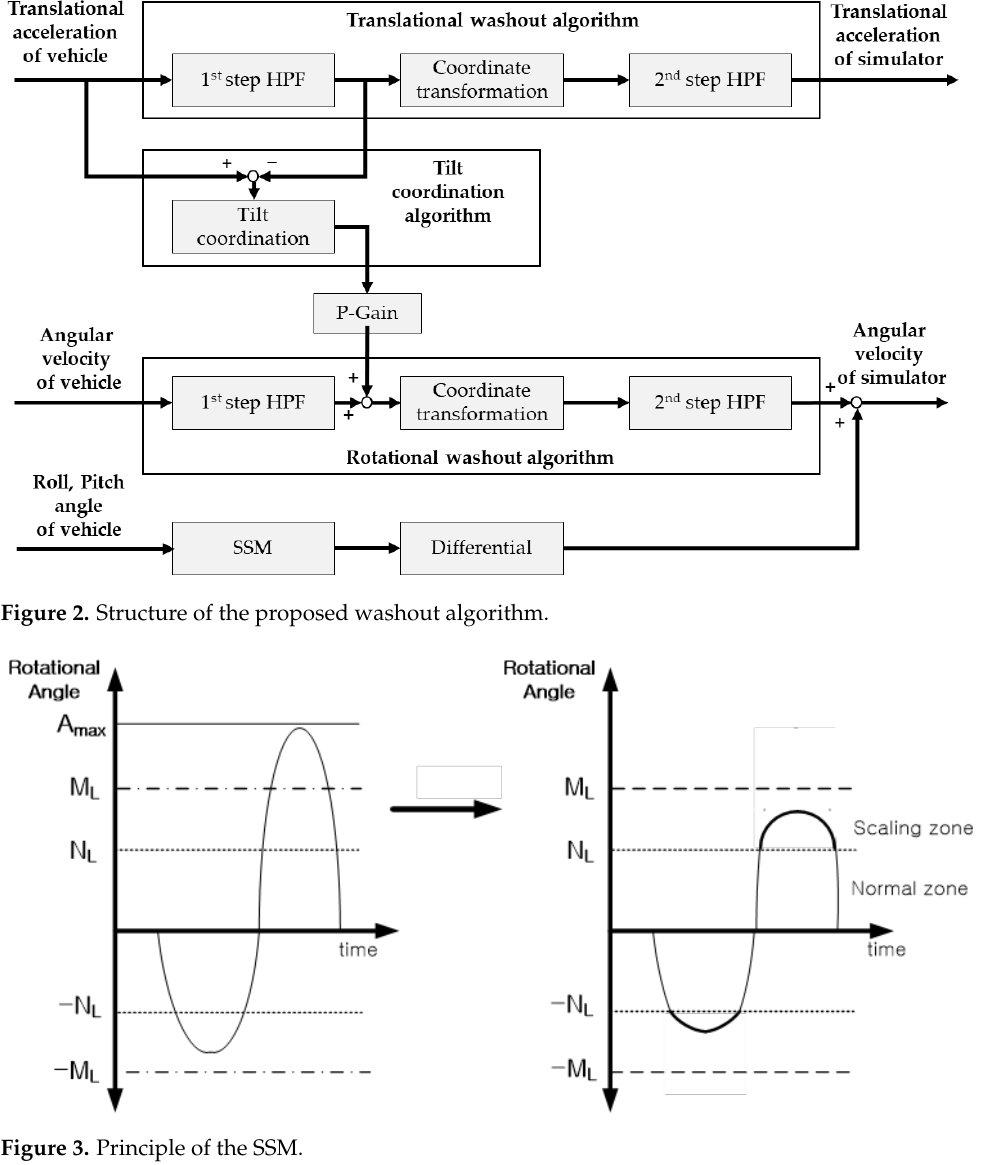
Figure 3. Principle of the SSM.